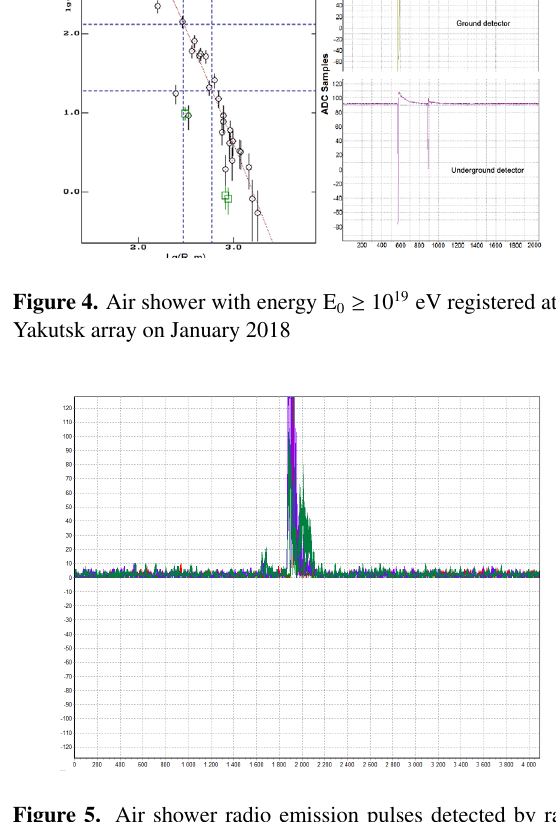
Figure 5. Air shower radio emission pulses detected by radio antennas with di ff erent radiation pattern